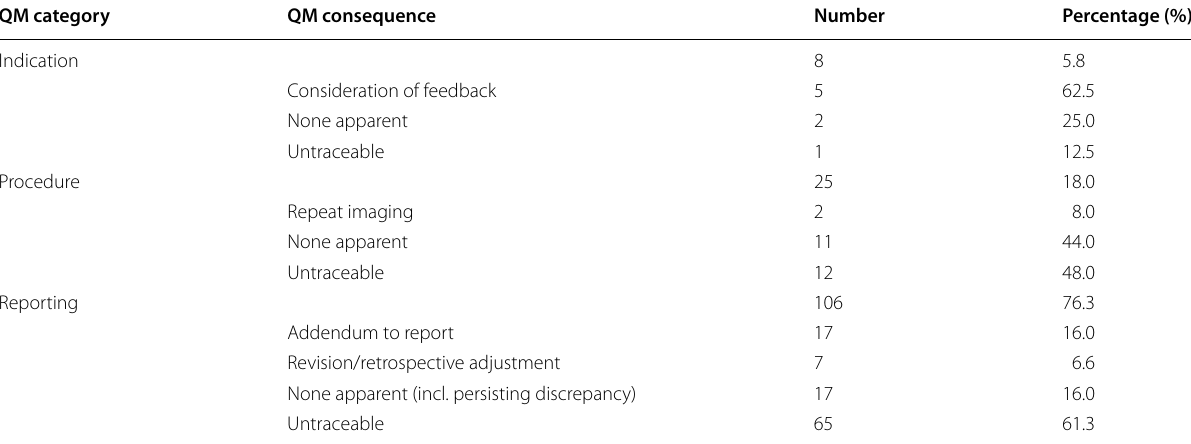
Table 3 Quality management (QM) consequences